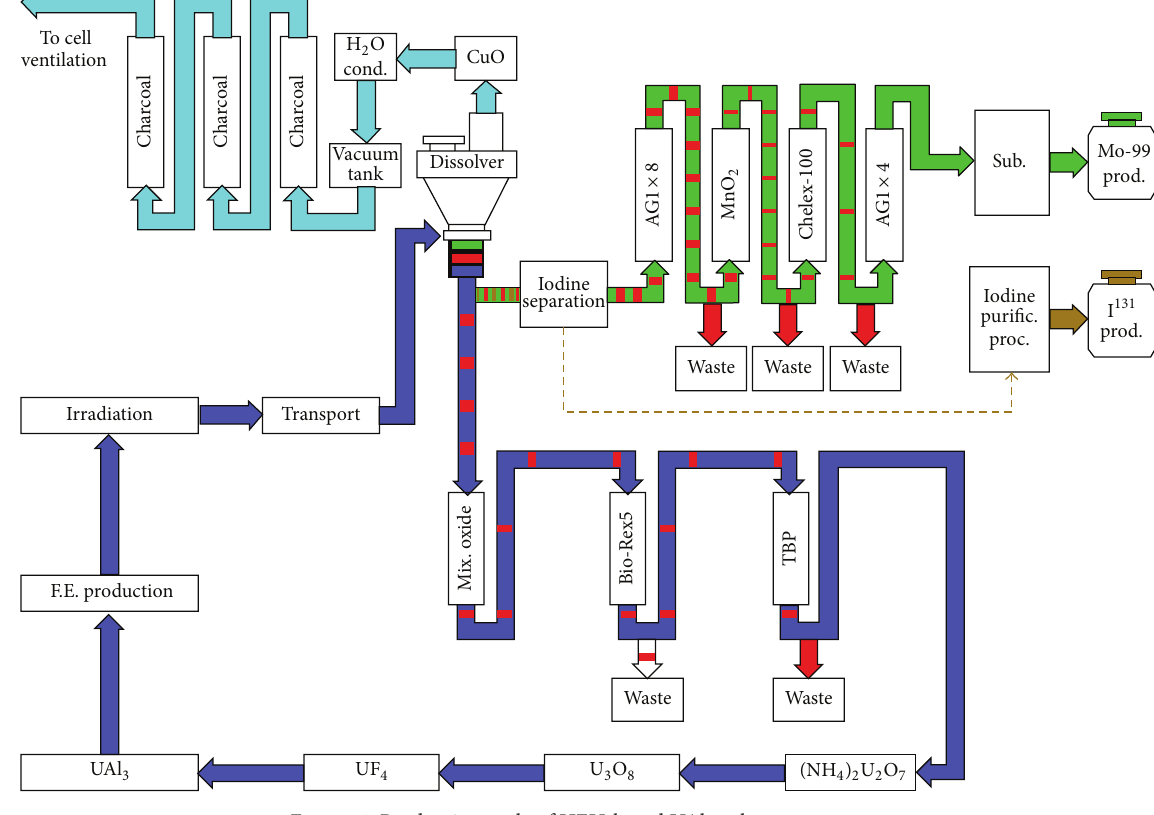
Figure 1: Production cycle of HEU-based UAl 𝑥 - plate-type targets.